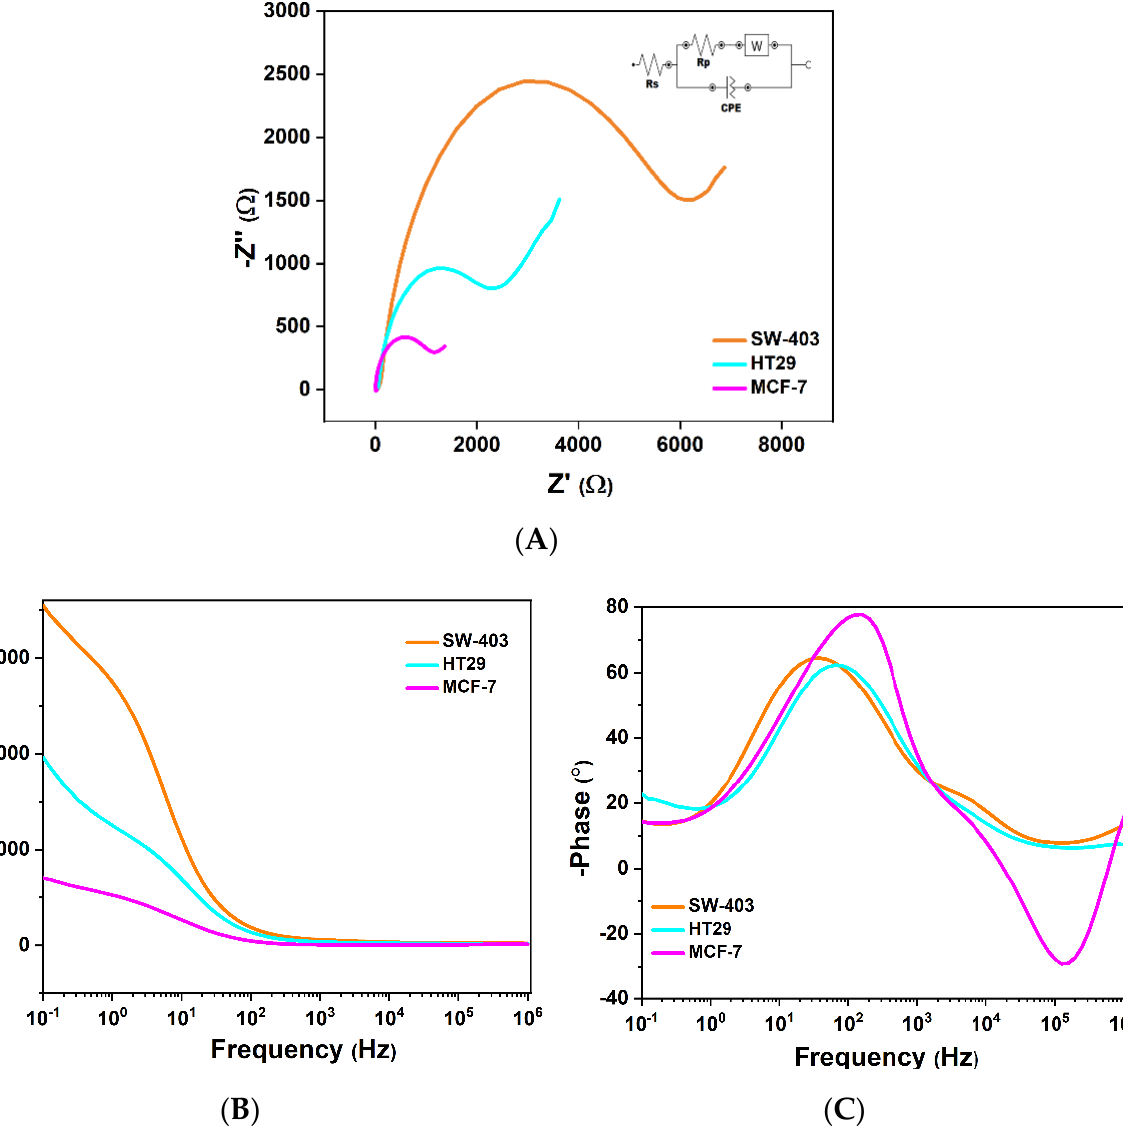
Figure 9. ( A ) Nyquist diagram; ( B , C ) Bode diagrams of the MCF-7, SW-403 and HT-29 cells from 0.1 to 10 6 Hz in PBS solution containing 1 mM [Fe (CN)6] 3−/4− and 0.1 M KCl. Table 1. Extracted impedance parameters found by fitting the experimentally measured